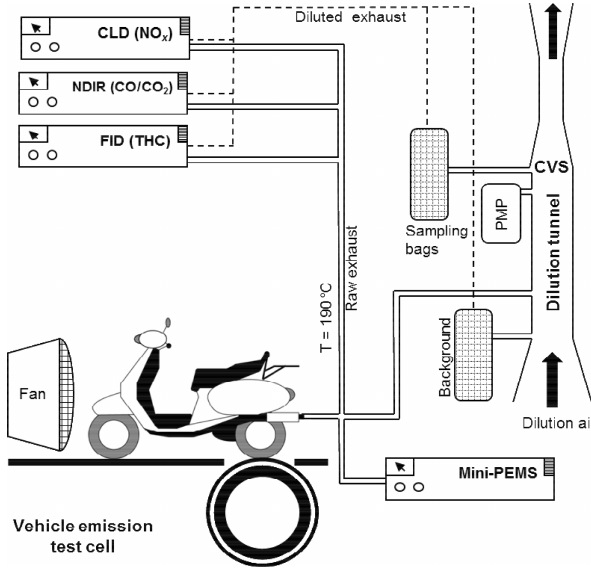
Figure 1. Schematic of the test cell and laboratory instrumenta- tion. Exhaust emission measurements are performed at the tailpipe and after dilution through a constant volume sampler (flow rate ≈ 5m 3 min − 1 ) by two independent gas analyzer systems. The Mini- PEMS collects part of the raw exhaust; see text for